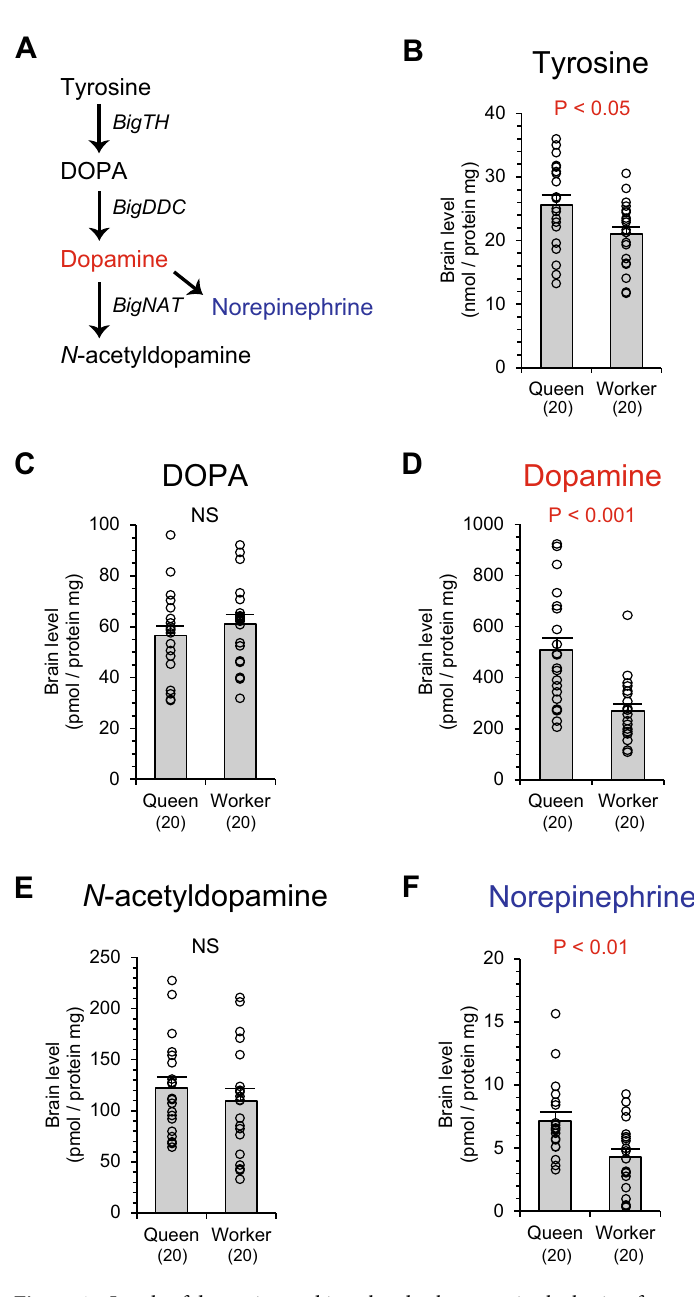
Figure 1. Levels of dopamine and its related substances in the brain of queens and workers in Bombus ignitus . Dopamine metabolic pathways are indicated ( A ). Dopamine is synthesized from tyrosine via DOPA and converted into N -acetyldopamine and norepinephrine. Enzyme genes mediating the biosynthetic reaction are indicated in italics. An enzyme gene converting norepinephrine has not been identified in insects. Dopamine is a functional monoamine (red) and norepinephrine is a potential functional monoamine (blue). Levels of tyrosine ( B ), DOPA ( C ), dopamine ( D ), N -acetyldopamine ( E ), and norepinephrine ( F ) in the brains of queens and workers are indicated. Numbers in parentheses indicate the number of samples examined. Data were obtained from 10 individuals in each caste per colony (two colonies). Individual data of biogenic amine levels were indicated by plots in graphs and in Table